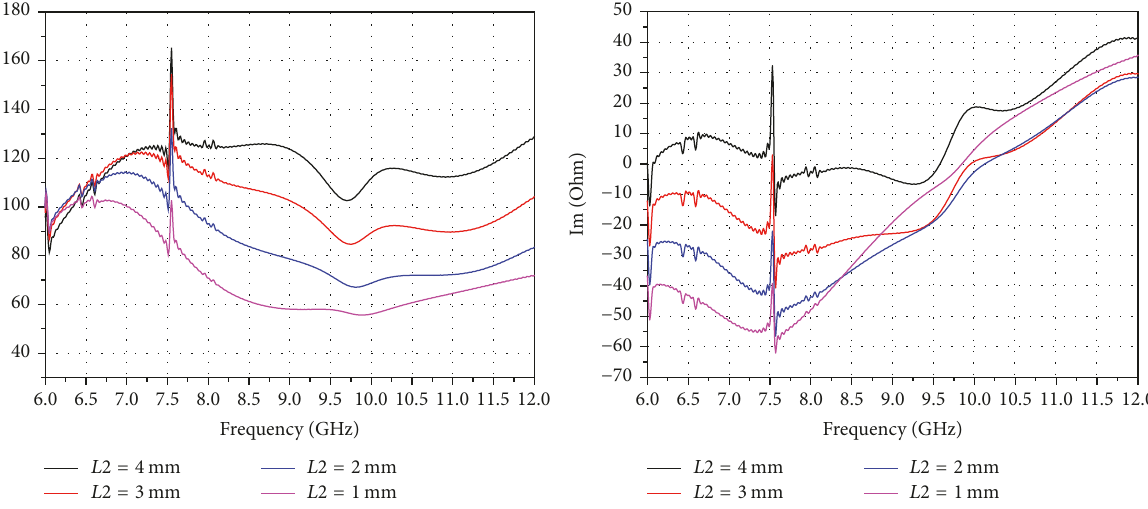
Figure 3: The real and imaginary parts of the 𝑍 𝑙 .